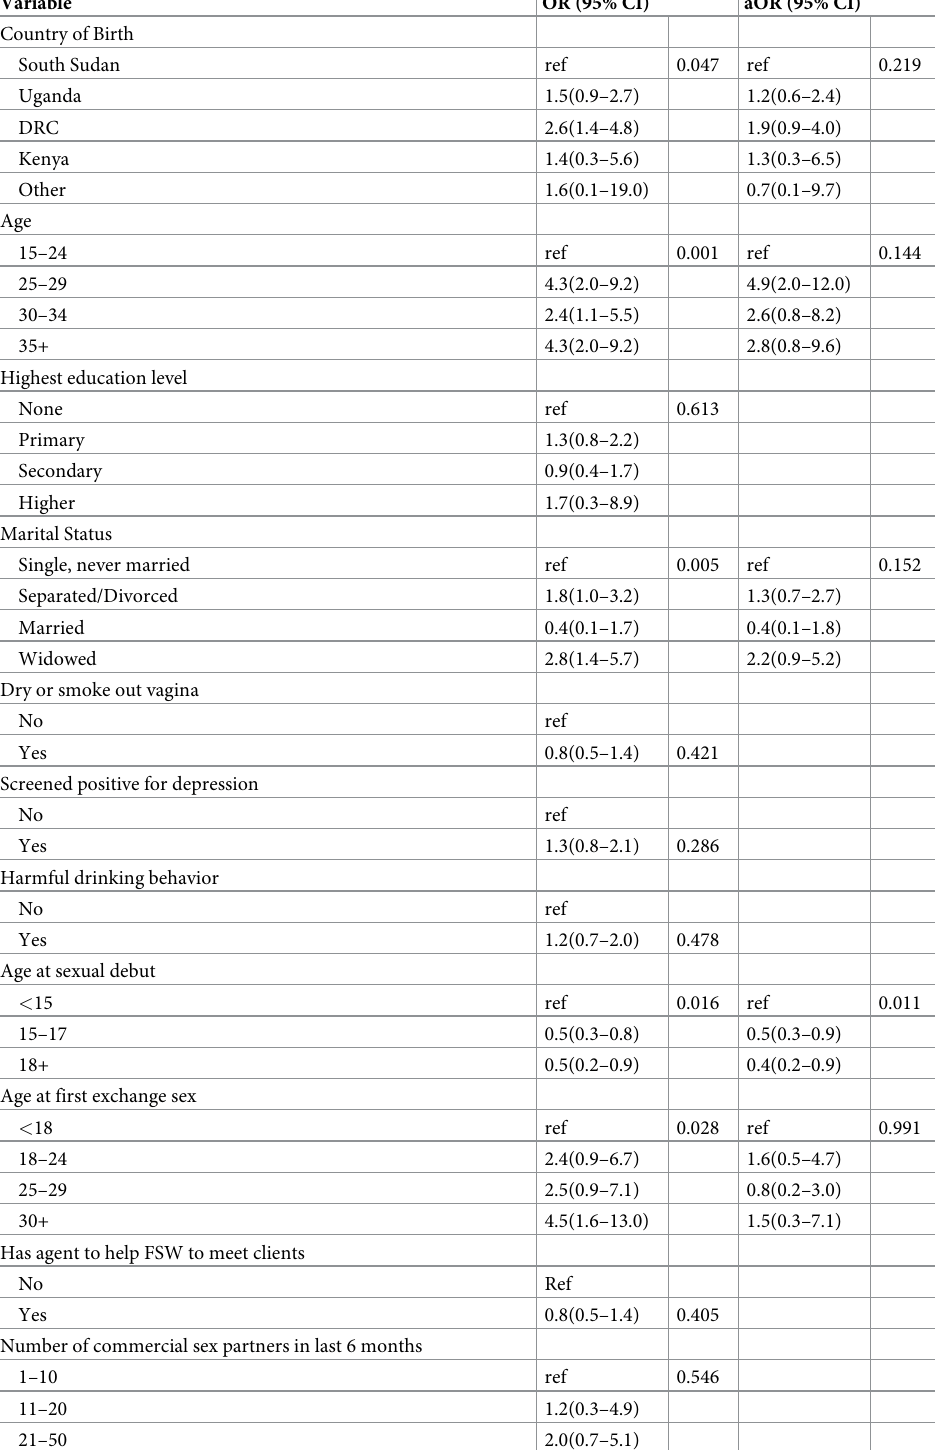
Table 5. Bivariate and multivariate associations of having undiagnosed HIV infection versus being HIV-negative (n =